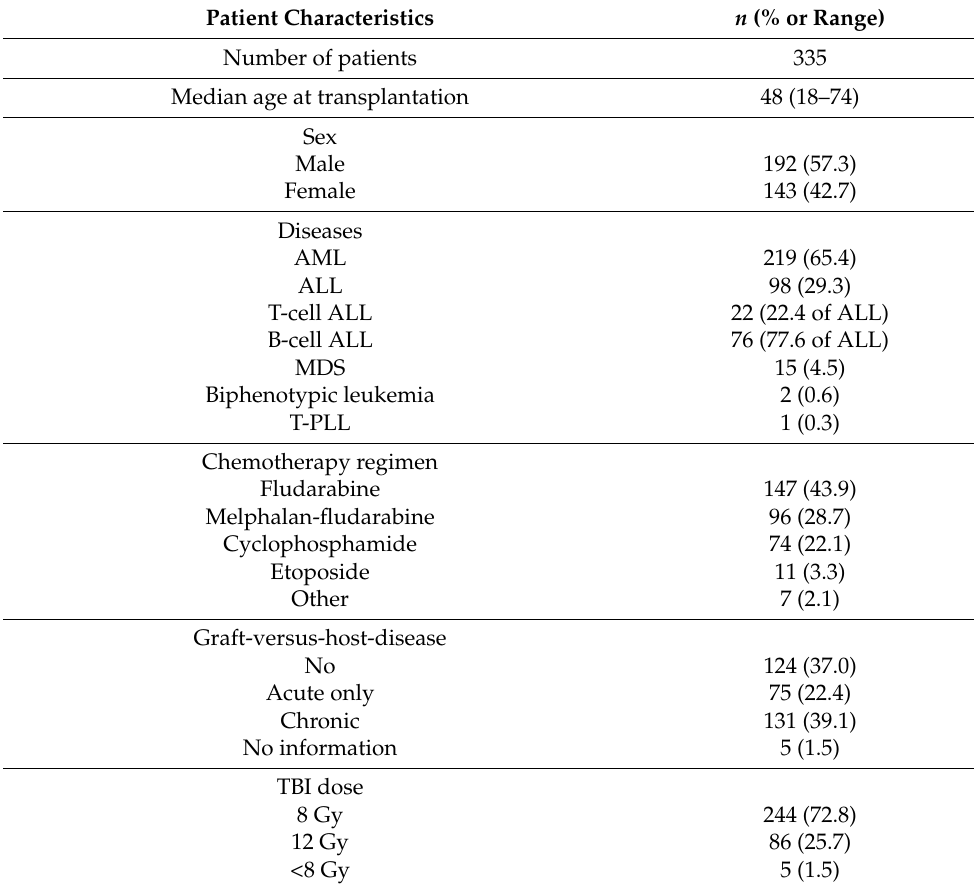
Table 1. Demographic basic data on clinical collective. ALL: acute lymphoid leukemia; AML: acute myeloid leukemia; Gy: Gray; MDS: myelodysplastic syndrome; PLL: prolymphocytic leukemia; TBI: total body irradiation.